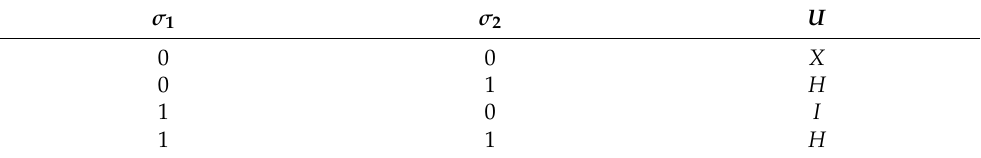
Table 1. Tabular representation of the quantum mapping of (2). σ